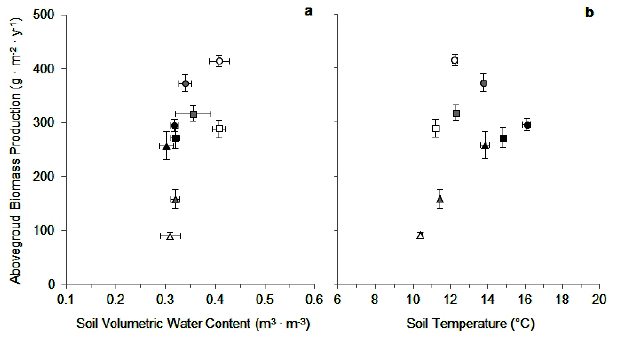
Fig. 3 . Change in aboveground biomass production in relation to (a) soil moisture and (b) soil temperature in unwooded pastures (circles), sparsely wooded pastures (squares), and densely wooded pastures (triangles). Altitudes of experimental plots were 570 m ASL (black symbols), 1010 m ASL (grey symbols), and 1350 m ASL (empty symbols).